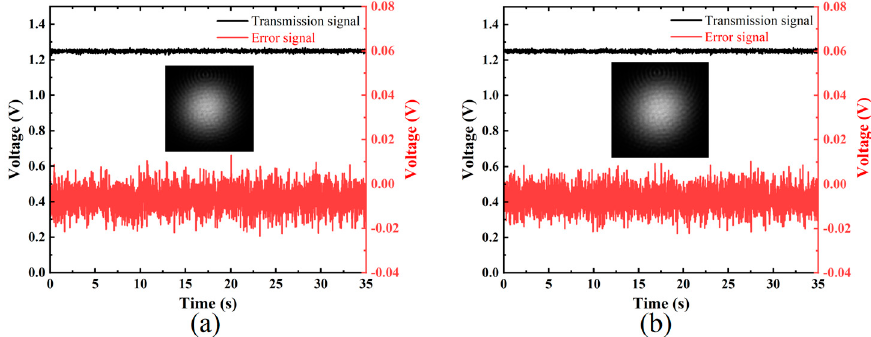
Figure 6. Transmission and error signals of the FP cavity ( a ) before and ( b ) after vibration tests. Table 3. Statical experimental data of transmission and error signals before and after vibration tests. Before Vibration